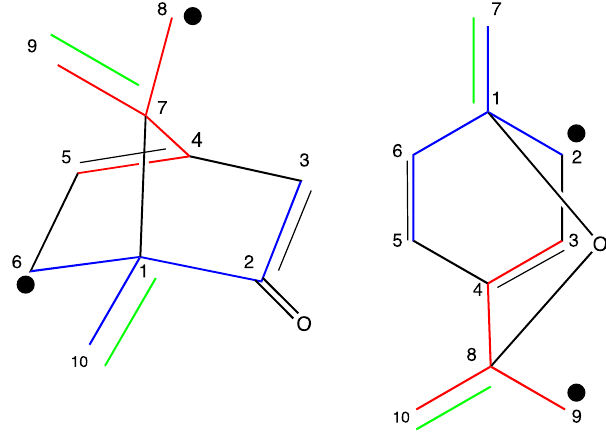
Figure 4. Numbering and biosynthetic origin of carbon atoms from camphor and 1,8-cineole synthesized via the MEP pathway. Carbon atoms derived from: DMAPP (red), IPP (blue), Pyruvate (Green), G3P (Black).